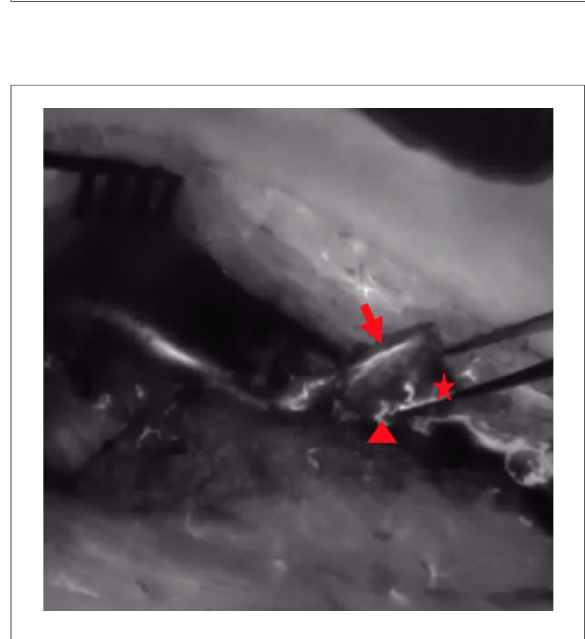
FIGURE 3 ( A ) 15 s after application of ICG dye: there is no NIR fl uorescence signal in the arterial vascular pedicle and the periosteum of the bone graft (arrow= arterial pedicle, star=corticocancellous MFC graft). ( B ) 30 s after application of ICG dye: the parental descending geniculate artery shows a fl uorescence signal (arrow=arterial pedicle, star=corticocancellous MFC graft). ( C ) 45 s after application of ICG dye: the parental descending geniculate artery and the periosteum show a fl uorescence signal (arrow=arterial pedicle, star=corticocancellous MFC graft). ICG, indocyanine green; NIR, near-infrared; MFC, medial femoral condyle.